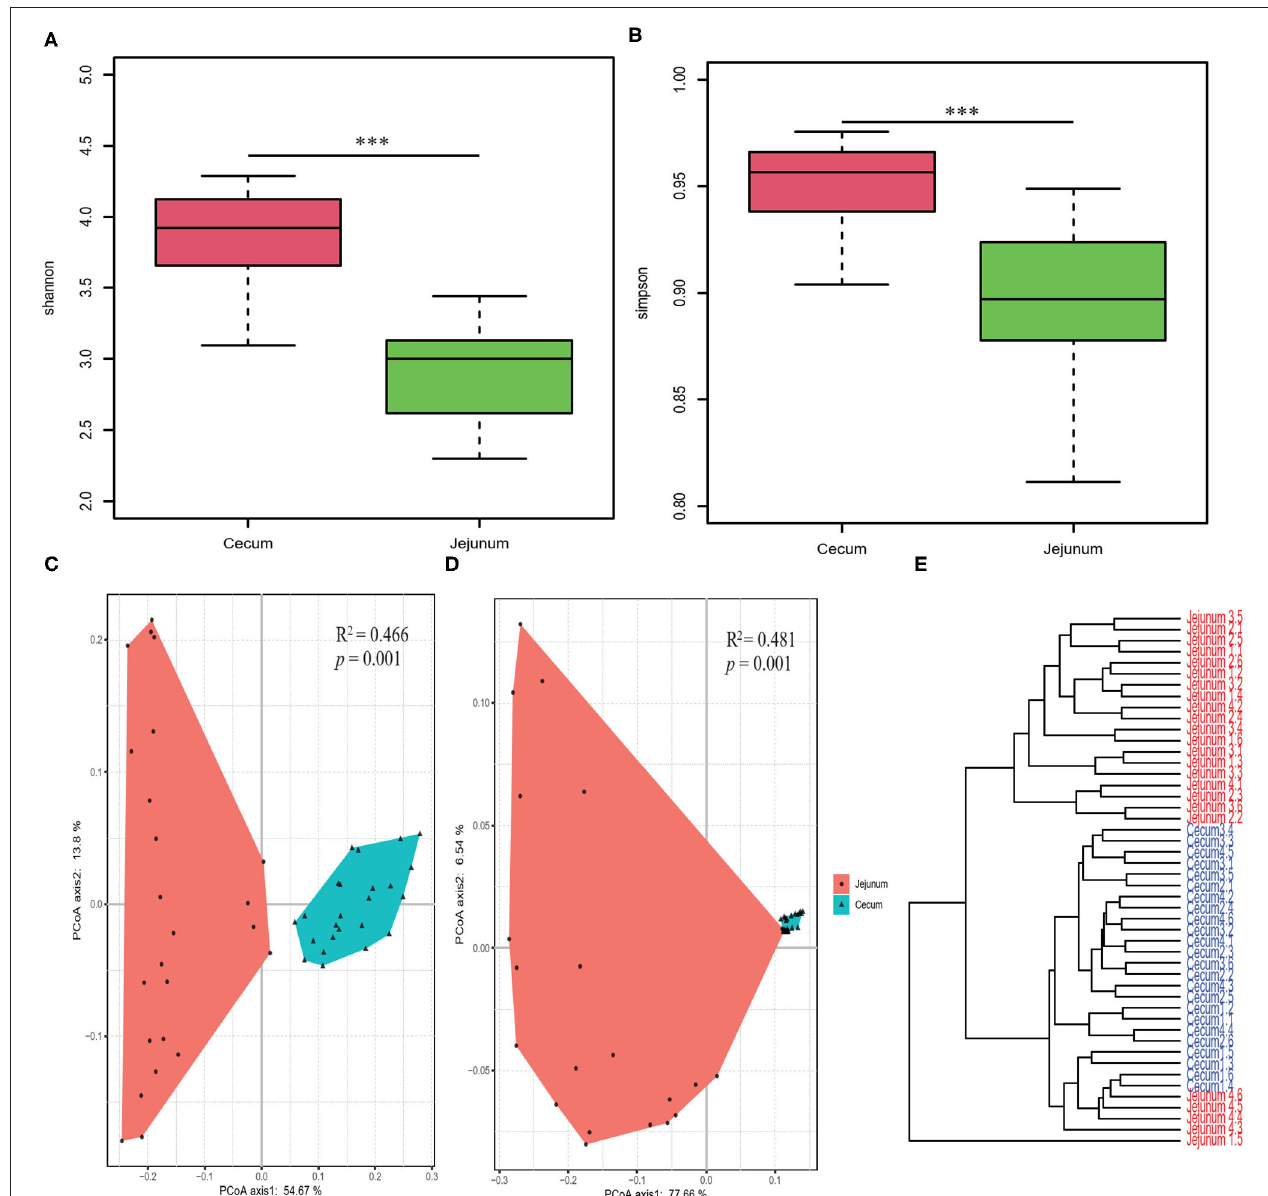
FIGURE 1 | Diversity analysis of core bacteria between two gut segments. The α - and β -diversity comparison for the cecum and jejunum. (A,B) Box plots showing significantly different α -diversity between the jejunal and cecal content samples by Wilcoxon test. PCoA based on weighted (C) and unweighted (D) UniFrac distances. Adonis tests show statistically significant differences between the cecum and jejunum. (E) Dendrogram analyses were performed based on the Bray Curtis distance. p values: *** p <